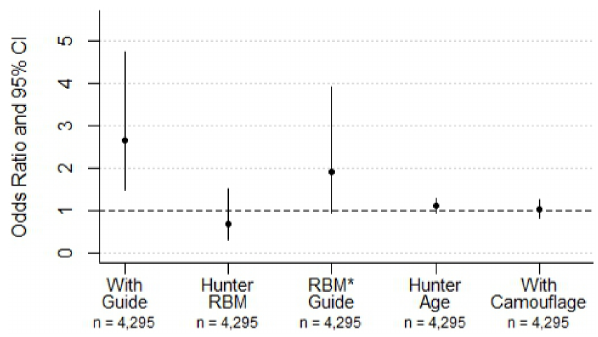
Figure 3. The odds of hunters from British Columbia and Alberta, Canada, displaying a large cervid carcass as a function of the presence of a guide, relative body mass (RBM), age, and camouflage clothing. Among unguided hunters, those with higher RBM had increased odds of killing large prey, though this effect was modest